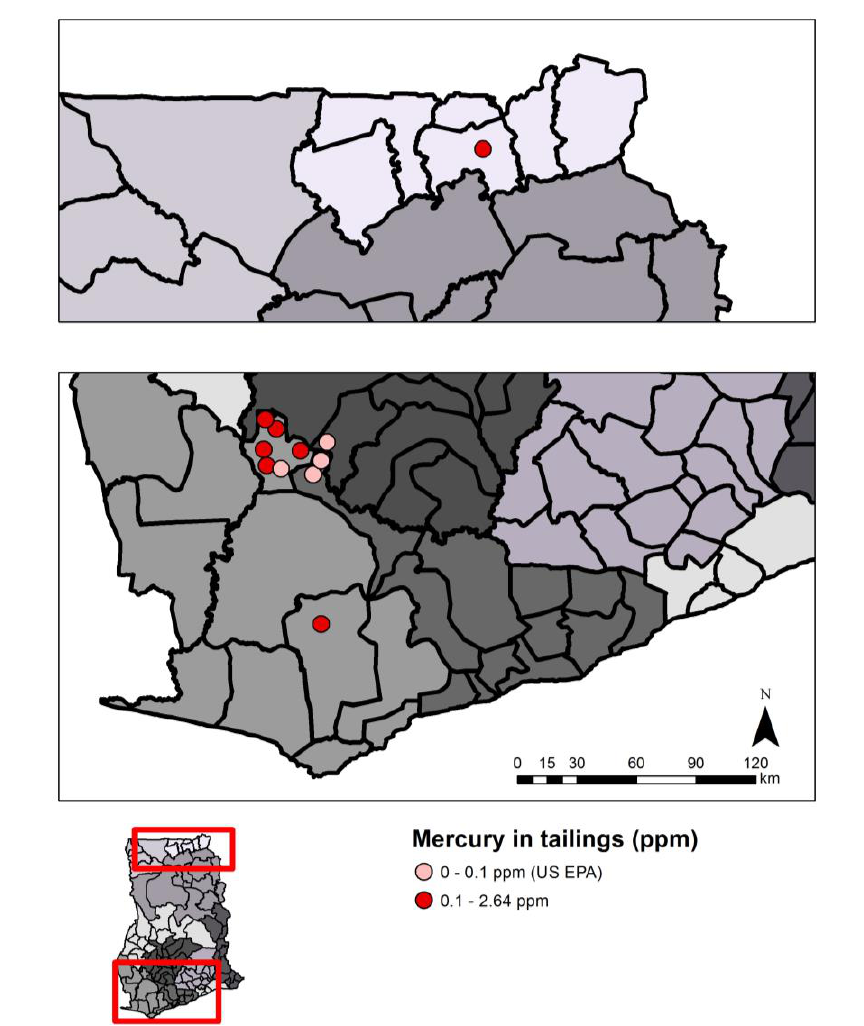
Figure 13. Mercury in tailings in southwest (bottom panel) and northern (upper panel) Ghana. Each circle represents the mean mercury value (µg/g or ppm) above or below the U.S. EPA guideline from a single study in that region, and for illustrative convenience the symbols are scattered randomly within the district where the sampling took place. Political regions are distinguished by different shades of grey. Samples were taken from dumps, dams, or sediments (surface and up to 60 cm) near current or former ASGM